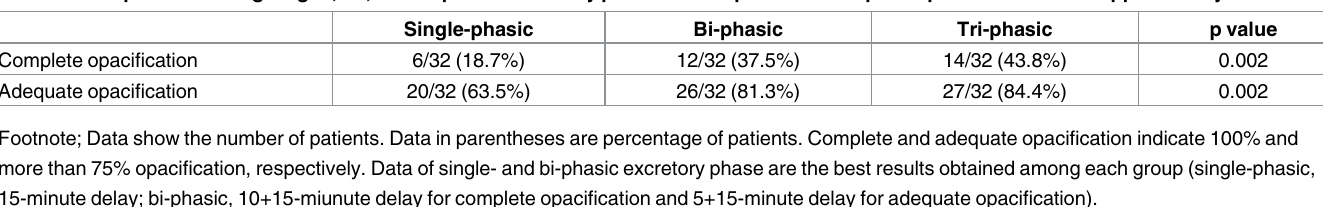
Table 3. Comparison among single-, bi-, and tri-phasic excretoryphase for complete and adequate opacification of the upper urinary tracts.